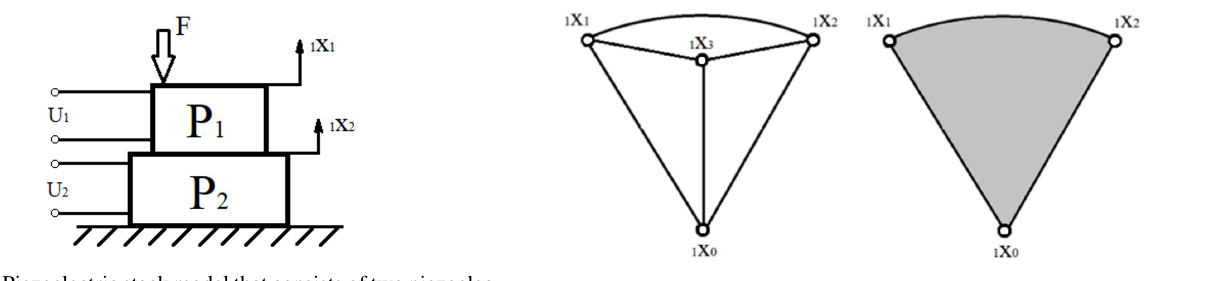
Figure 12. Graph and a hypergraph of relations in a single non- constrained piezoelectric plate (Buchacz and Wróbel, 2010).